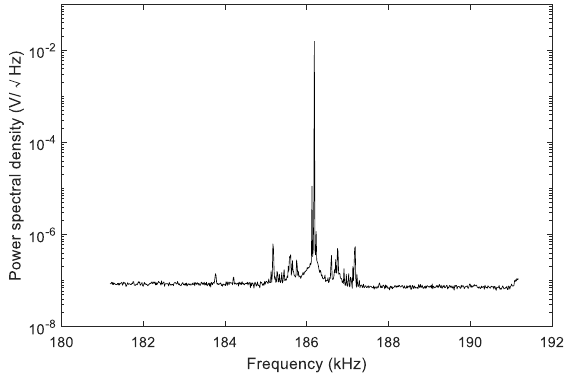
Figure 14. Root power spectral density measured by FSV4.